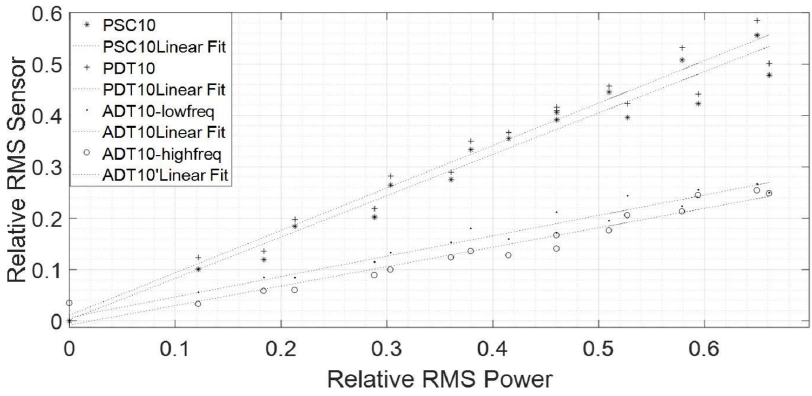
Figure 15. Correlation x RMS − POWER and x RMS for the different